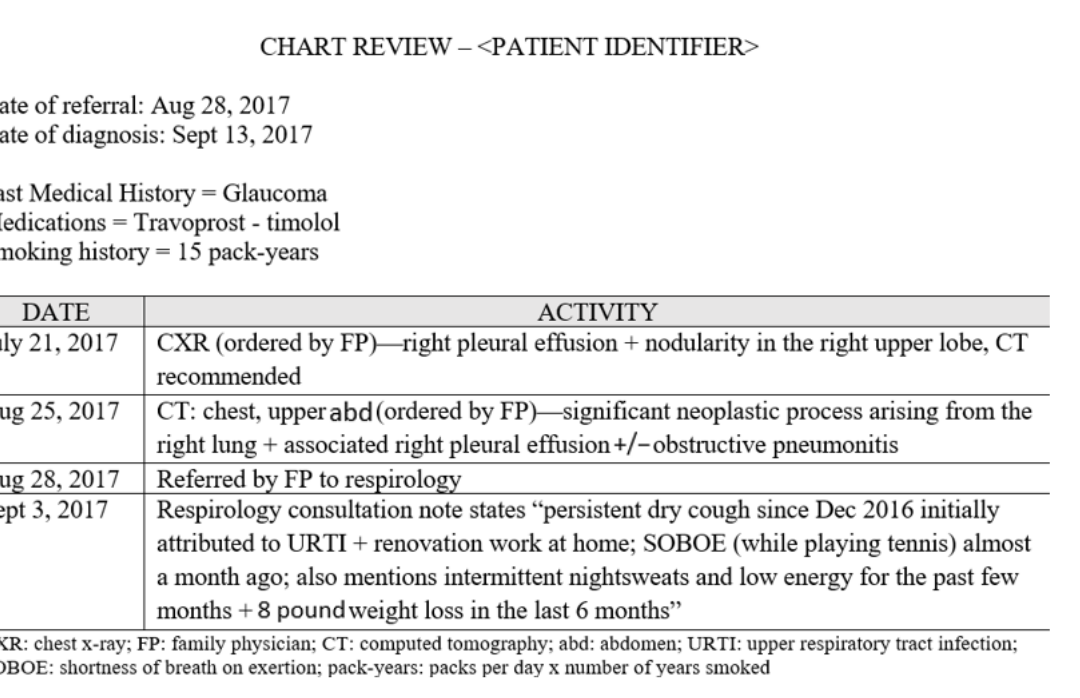
Figure 1. Chart review conducted on a patient from one year prior to their referral date to one month after their diagnosis date.